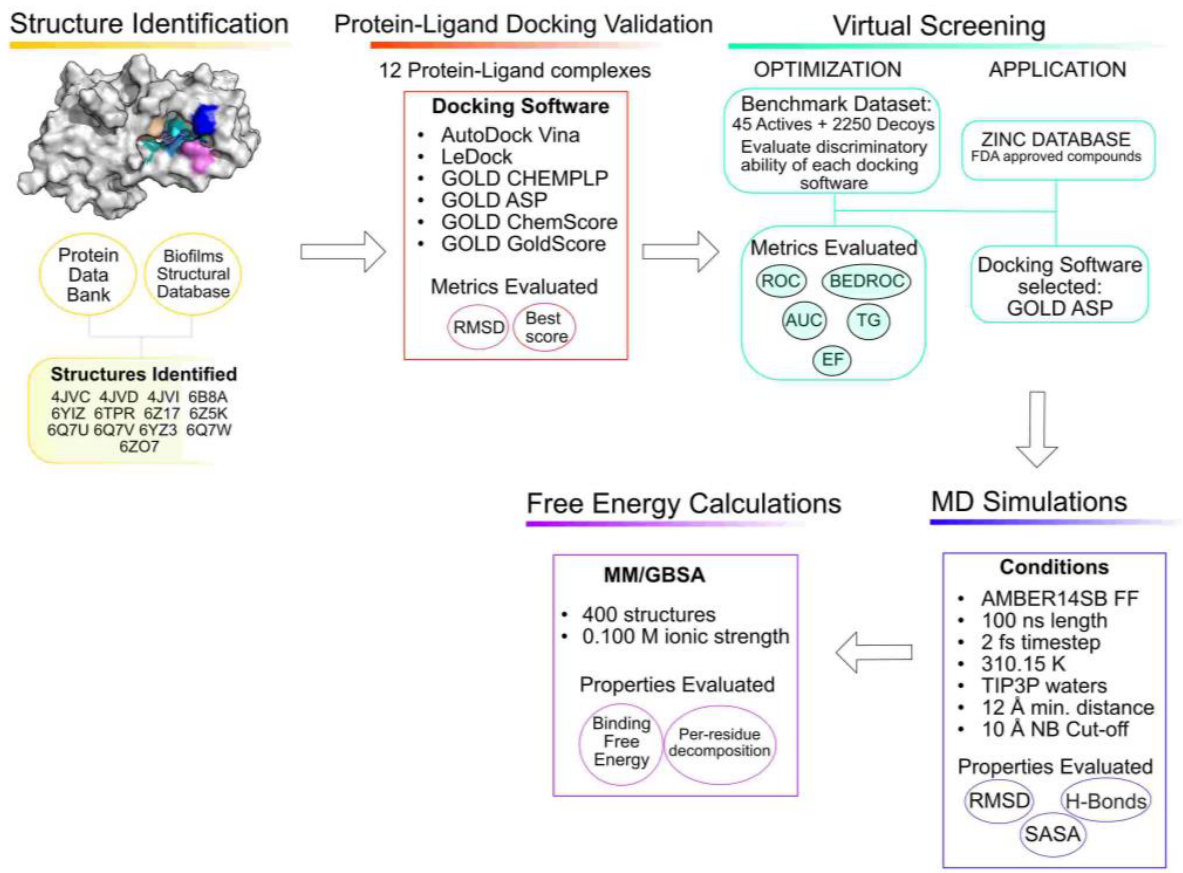
Figure 9. Workflow of the current study.